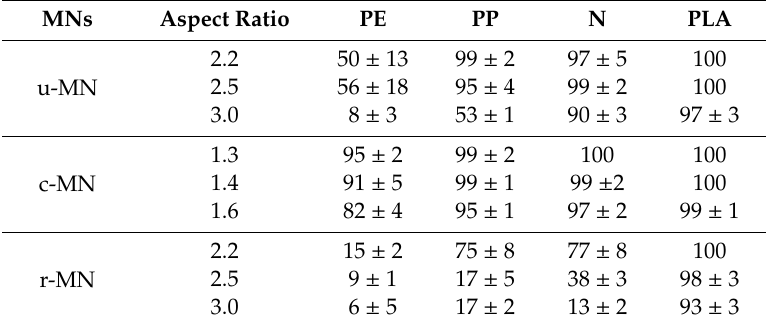
(polyethylene (PE), polypropylene (PP), nylon (N), polylactic acid (PLA)) and the aspect ratio.